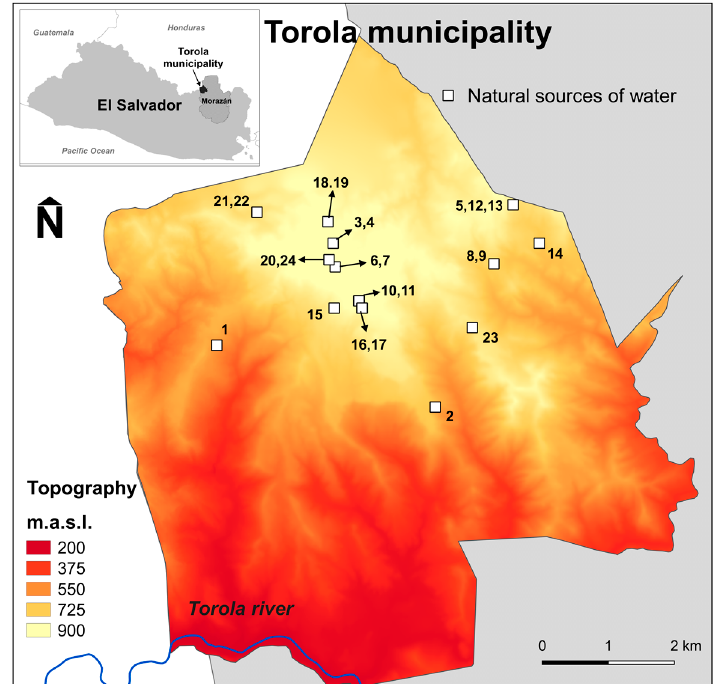
Figure 1. Map of El Salvador highlighting the municipality of Torola, the Department of Morazán, and the Torola River. Sampling sites. Code, 1: T. La Caída; 2: W. Cerritos; 3: T. El Picacho; 4: W. El